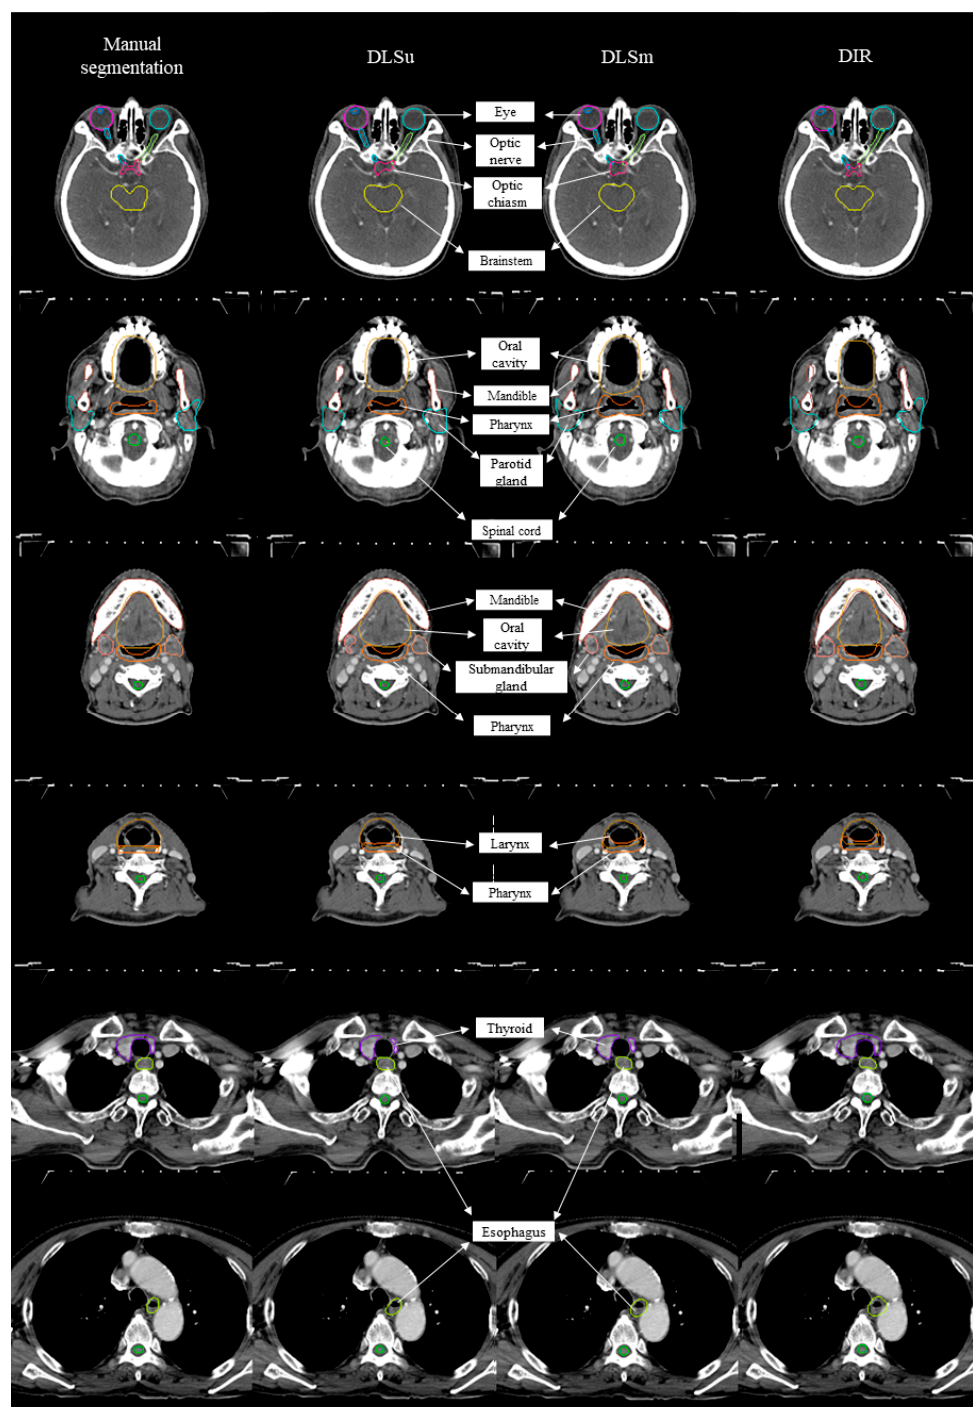
Figure 2. Examples of manual contour, deep learning-based segmentation based on the unmatched training set (DLSu) and matched training set (DLSm) and deformable image registration